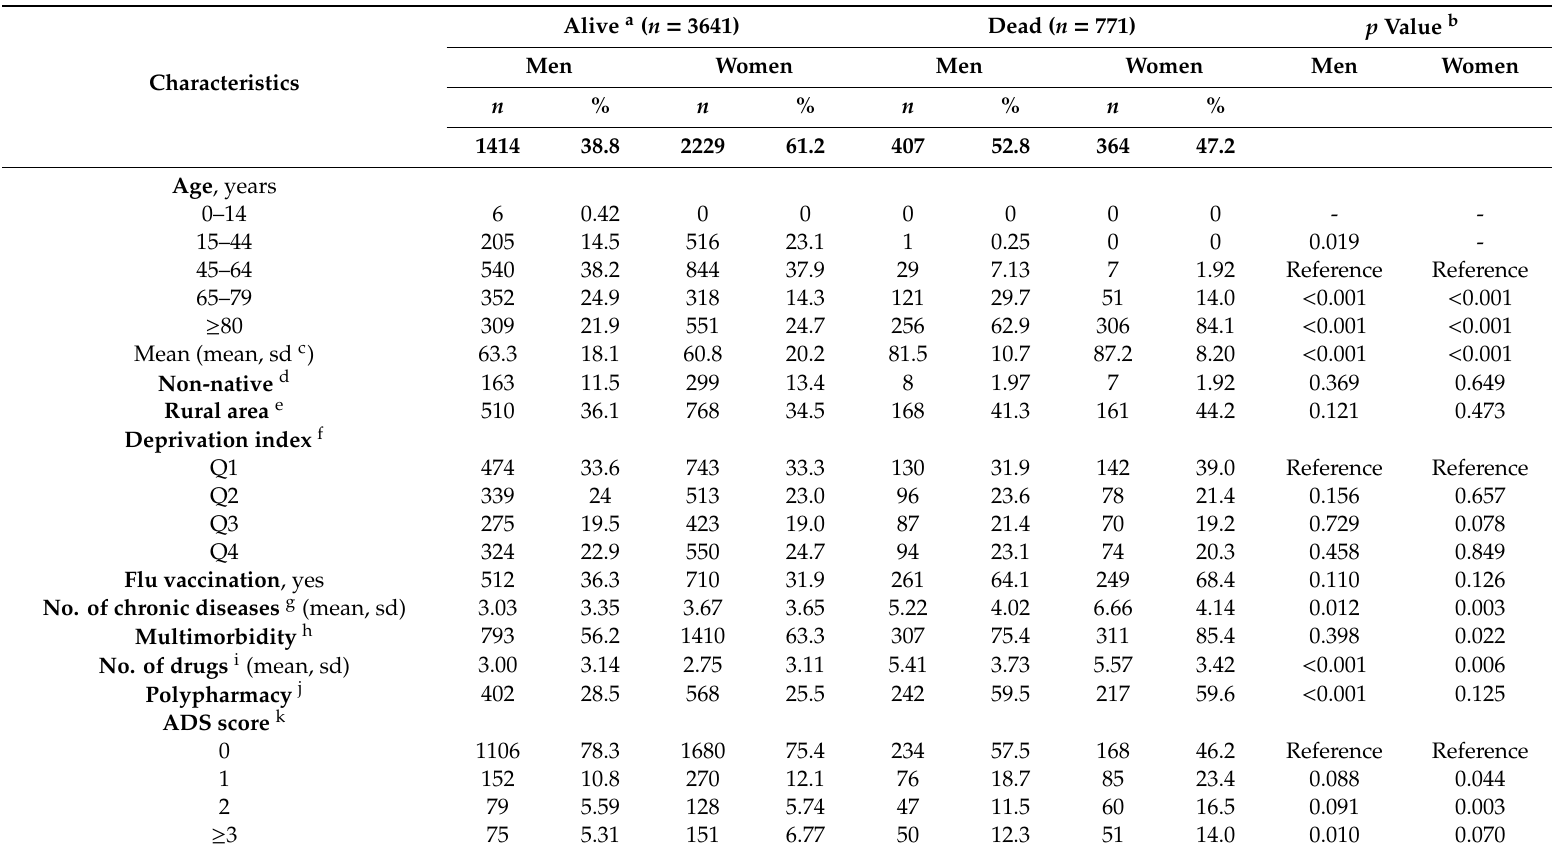
Table 1. Socio-demographic and clinical characteristics at cohort entry of the individuals with laboratory-confirmed infection by COVID-19 in Arag ó n, Spain, March to May 2020 ( n = 4412), by